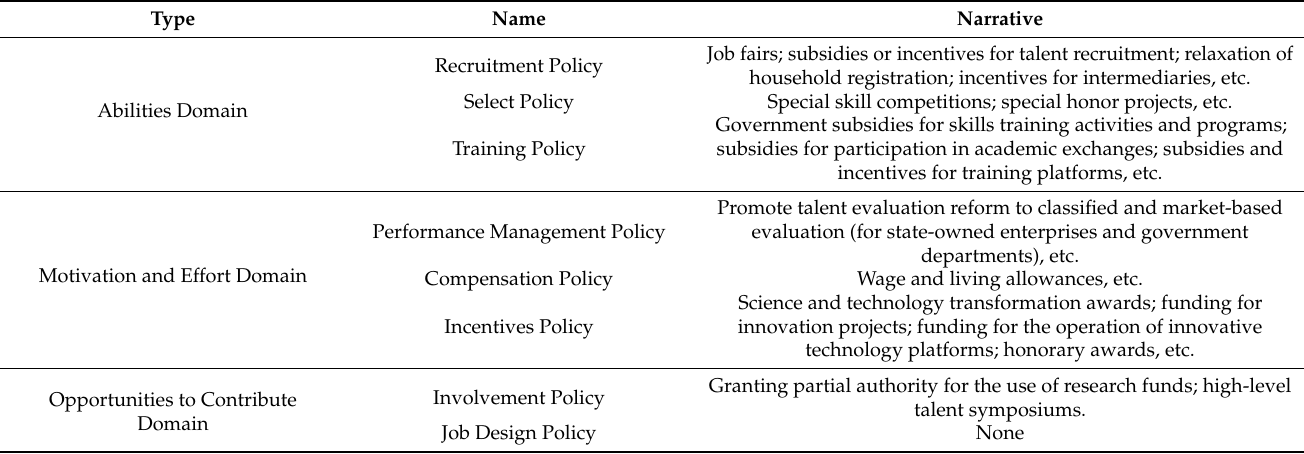
Table 1. Government support for talent policies (GSTP) in the abilitity-motivation-opportunity